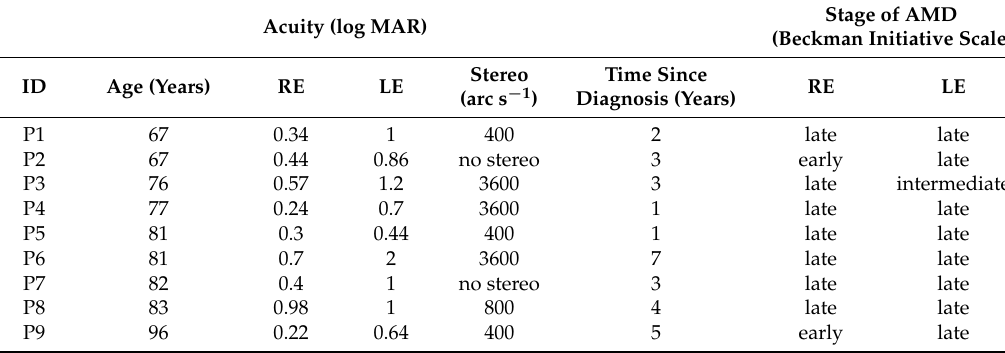
Table 1. Demographic and clinical characteristics of the participants with age-related macular degeneration (AMD).